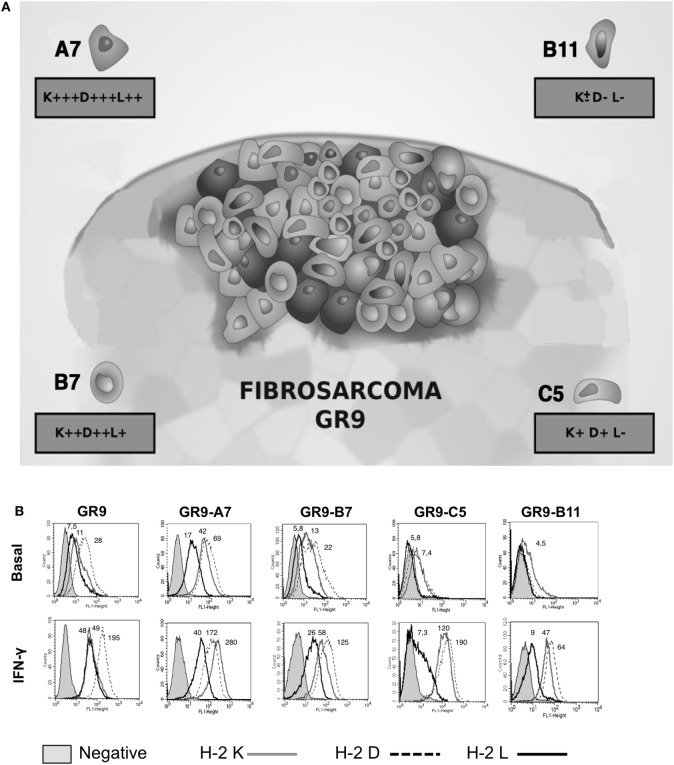
(A) MHC-I intratumoral heterogeneity in MCA-induced fibrosarcoma GR9; (B) H-2 class I surface expression of GR9, GR9-A7, GR9-B7, GR9-C5, and GR9-B11 clone cell lines in baseline conditions and after treatment with IFN-γ (100 U/ml) for 48 h: H-2 Kd (gray line), H-2 Dd
(dotted line), and H-2 Ld (black line). GR9-A7 showed high levels of H-2 class I expression, GR9 and GR9-B7 showed intermediate levels, and GR9-C5 low levels, while GR9-B11 is practically negative in baseline conditions; all three molecules were induced after IFN-γ treatment in all GR9 clones. Data from one experiment are depicted.